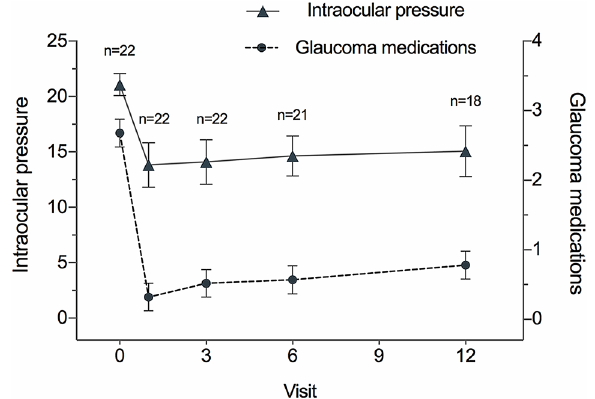
Figure 1. Serial changes of intraocular pressure (IOP) and glaucoma medications from baseline at each follow-up visit. The IOP was significantly decreased at each follow-up visit (1 month: p < 0.01; 3 months: p < 0.01; 6 months: p < 0.01; 12 months: p = 0.001, respectively). The IOP-lowering medications was significantly decreased at each follow-up visit (1 month: p < 0.01; 3 months: p < 0.01; 6 months: p < 0.01; 12 months: p < 0.01, respectively).